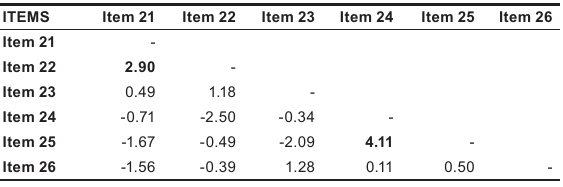
TABLE 8 Standardised residuals for Institutional dimension – Mall intercept study